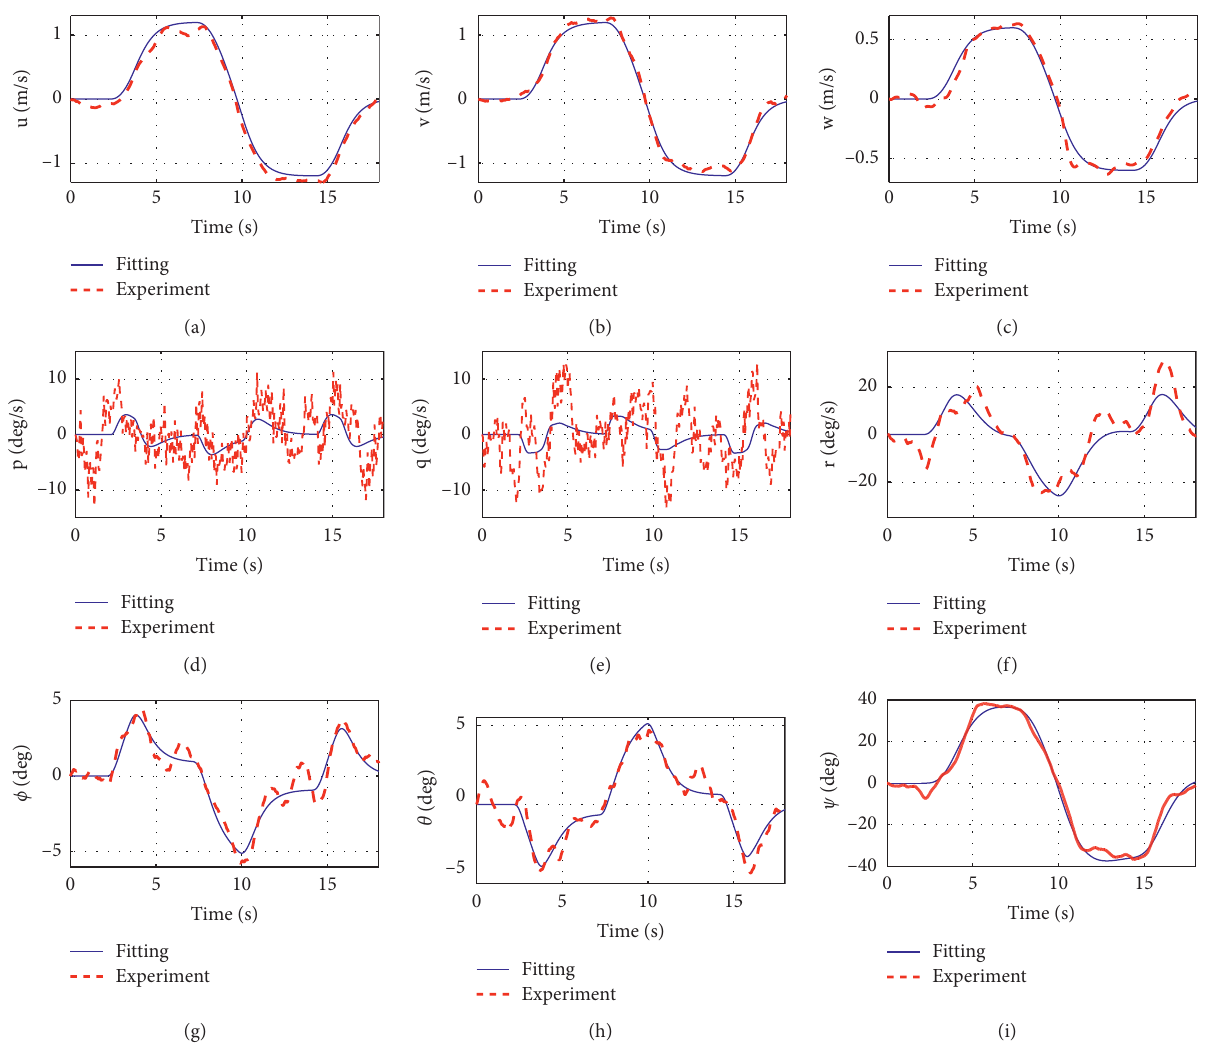
Figure 10: Time-domain verification of the identified